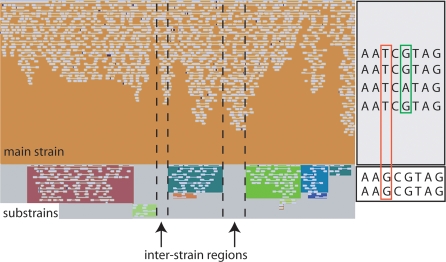
Schematic Illustrating How Strains Were Separated for Population Genetic AnalysesLeft: screenshot of contig 11111 (located near the origin of replication) from Strainer. Individual reads are shown as white blocks. Strains defined by shared polymorphisms are shown in distinct colors, with the main strain in orange. The vertical dashed lines indicate regions within the main strain not overlapped by any substrain and referred to as “intersubstrain regions” in the main text.Right: schematic illustrating the identification of polymorphisms within and between strains. The orange box surrounds a site classified as a fixed difference between the main strain and a substrain. The green box surrounds a site classified as polymorphic (three Gs, one A in the main strain; two Gs in the substrain).